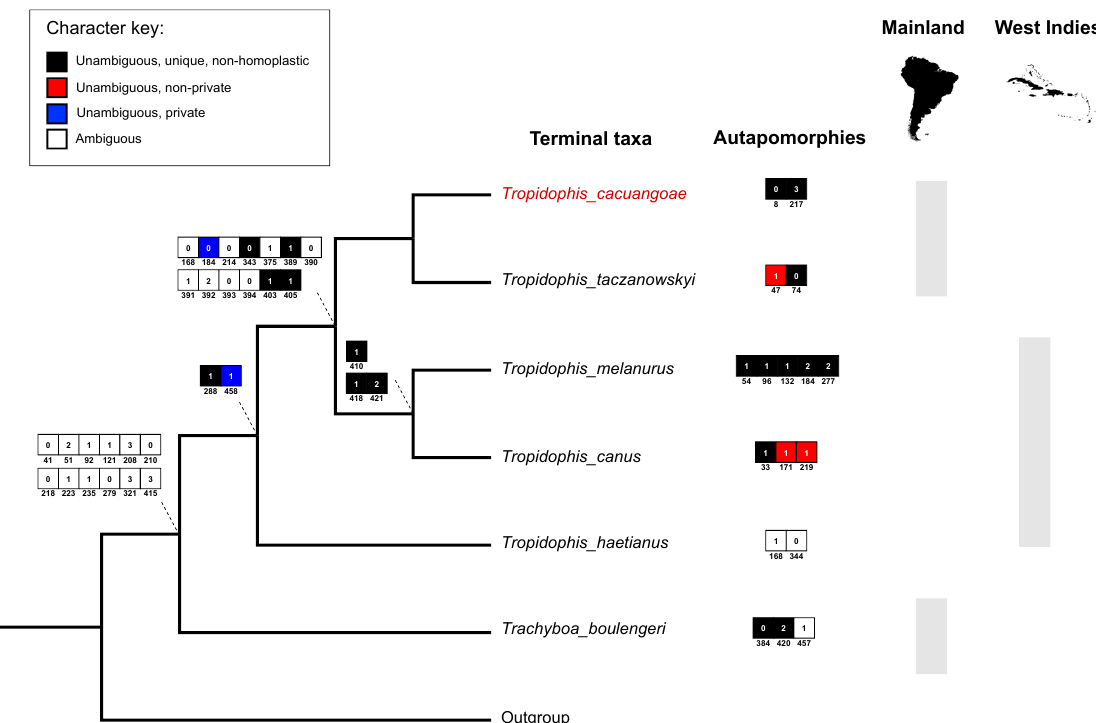
Fig. 19. Parsimony-based morphological character optimization over molecular phylogenetic tree of sampled species of Tropidophiidae Brongersma, 1951, as inferred with YBYRÁ software, and occurrence of species in South America and the West Indies. Left: Nodes are labeled with unambiguously optimized morphological synapomorphic characters (black square = unique, non-homoplastic; red square = non- unique, homoplastic; blue square = unique, homoplastic; character number = value below or above squares; derived character-states = value inside squares). Right: Geographic distribution of sampled terminals of